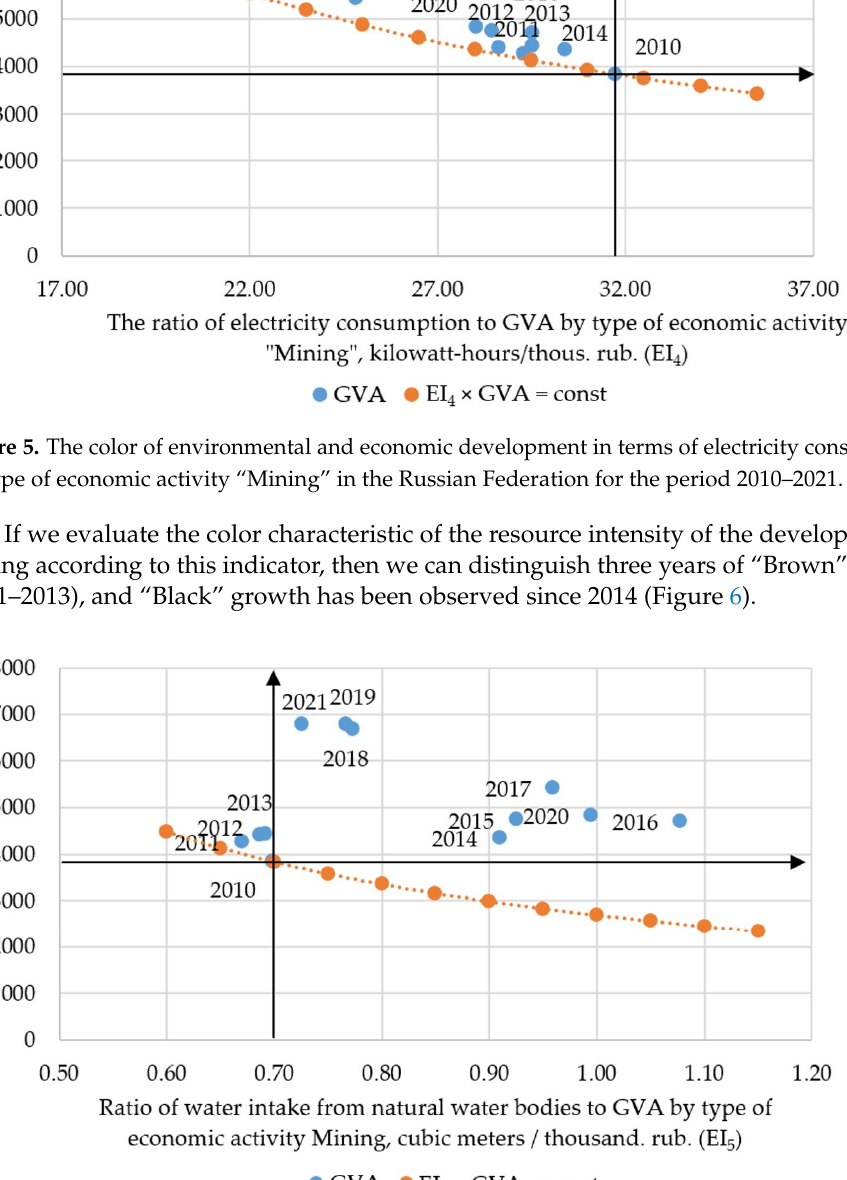
Figure 6. The color of environmental and economic development in terms of water intake from nat- ural water bodies by type of economic activity “Mining” in the Russian Federation for the period 2010–2021.